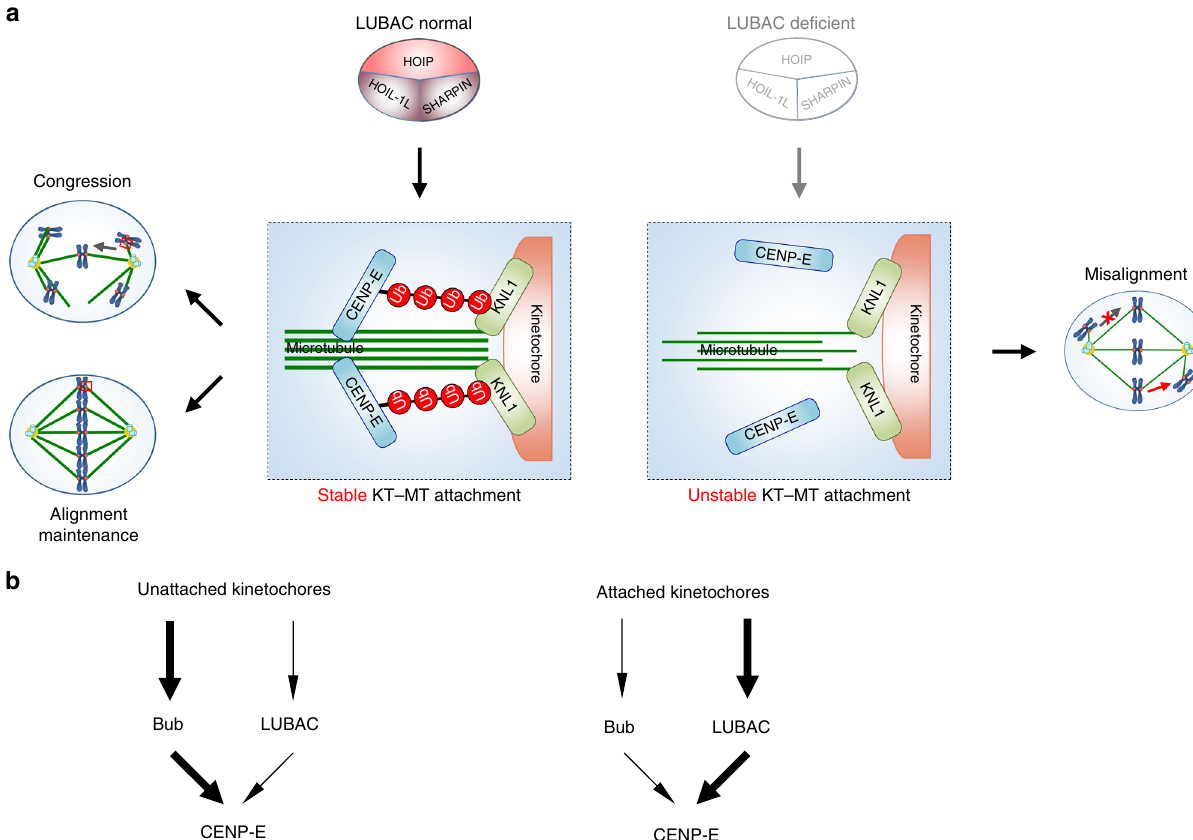
Fig. 7 The linear ubiquitin chains of CENP-E anchor it at attached kinetochores. a Model of LUBAC controlling chromosome congression and alignment maintenance by mediating the linear ubiquitination of CENP-E. KNL1 then anchors the linear ubiquitin chains on CENP-E at attached kinetochores. b At unattached kinetochores, CENP-E is mainly recruited by the Bub1-Bub3 and BubR1-Bub3 complexes (left). Once microtubule attachment releases these recruiters, LUBAC-mediated linear ubiquitination of CENP-E is responsible for anchoring it at attached kinetochores